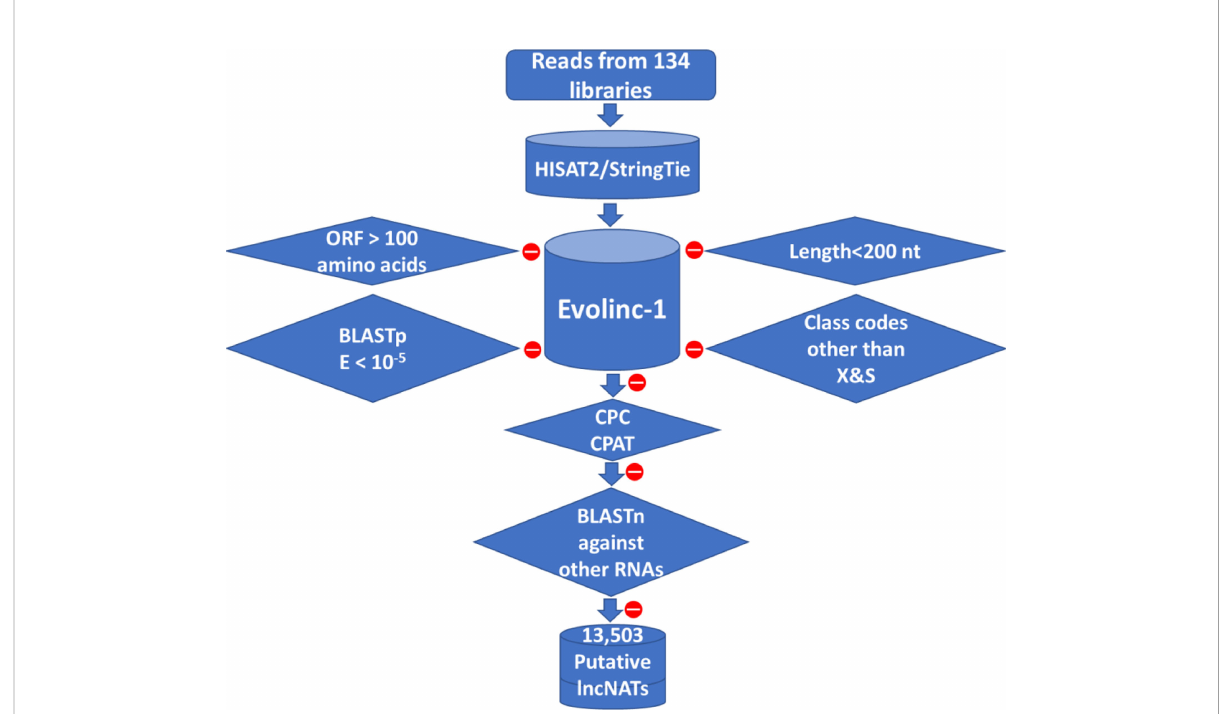
FIGURE 1 Bioinformatics pipeline used to predict lncNAT transcripts in rainbow trout. LncNATs were identi fi ed from 134 RNA-Seq datasets according to their length, coding potential, genomic location, and orientation relative to known genes. A total of 13,503 lncNAT transcripts were identi fi ed from all datasets. Filtration criteria applied to the assembled transcripts are represented in diamond shapes. Red circles mean transcripts were removed from the assembled pool of transcripts based on the shown fi ltration